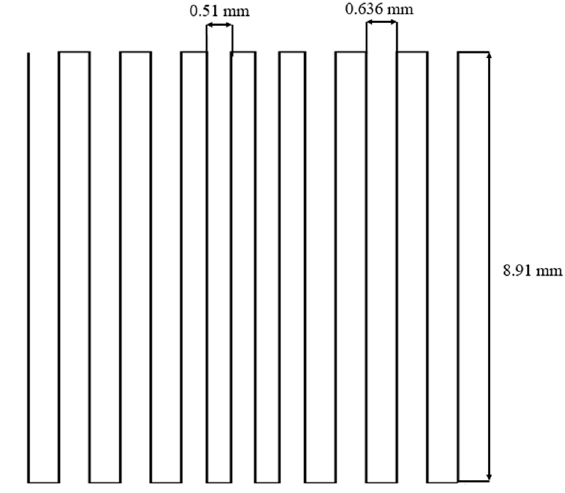
Figure 11. Raster pattern followed by the printing head.